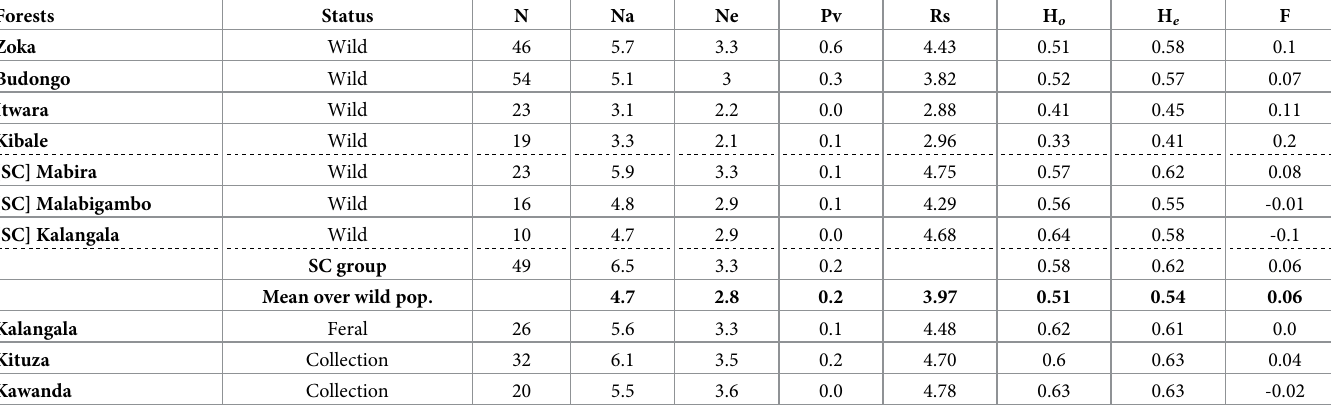
Table 2. Allelic pattern across populations. Values are provided for each native forest, the feral population and the two collections: Number of alleles, number of effec- tive alleles, number of private alleles, allelic richness, observed and expected heterozygosities, and fixation index. Since Mabira, Malabigambo and Kalangala belong to the same south-central genetic group [SC], data are also provided for this group.